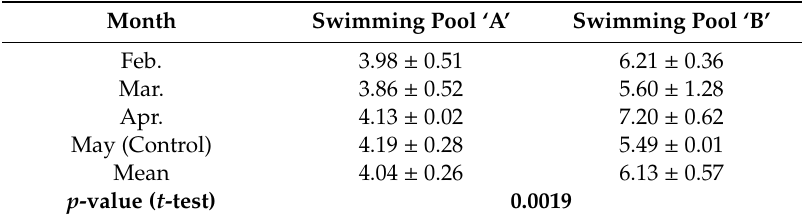
Table 2. Mean and p -values of pH of swimming pool waters in the Tamale Metropolis. Month